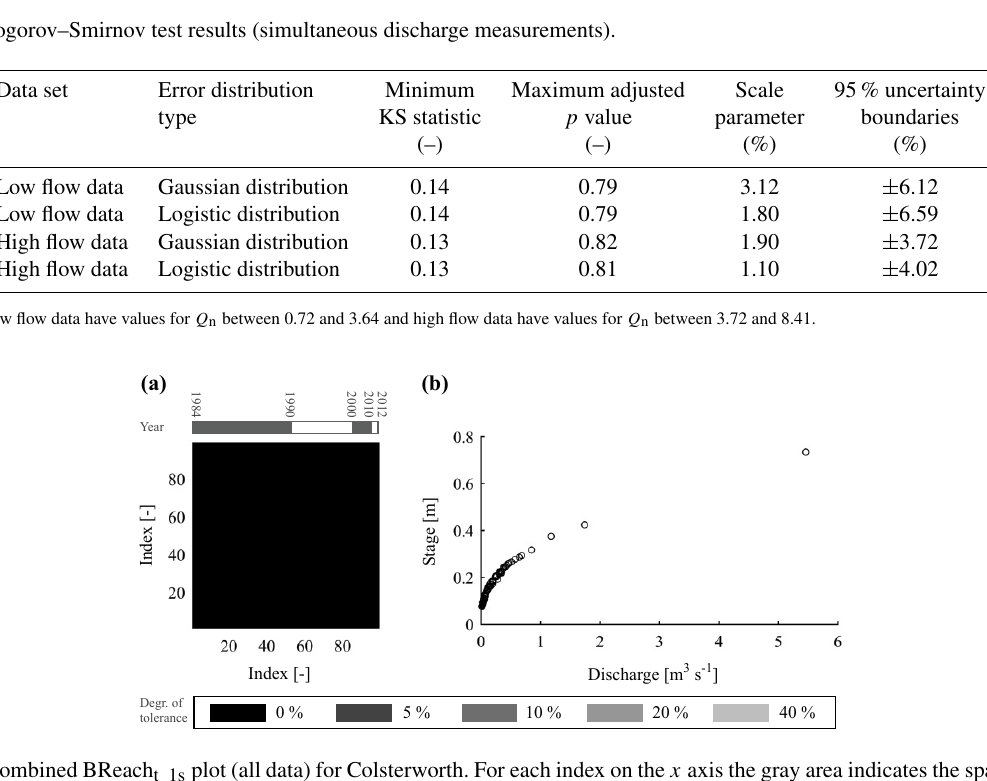
Figure 2. (a) Combined BReach t_1s plot (all data) for Colsterworth. For each index on the x axis the gray area indicates the span between the index of the maximum left reach (under the bisector) and the maximum right reach (above the bisector). Each gray tint represents a different degree of tolerance (i.e., percentage of data points allowed to have nonacceptable model results). (b) Stage–discharge data for